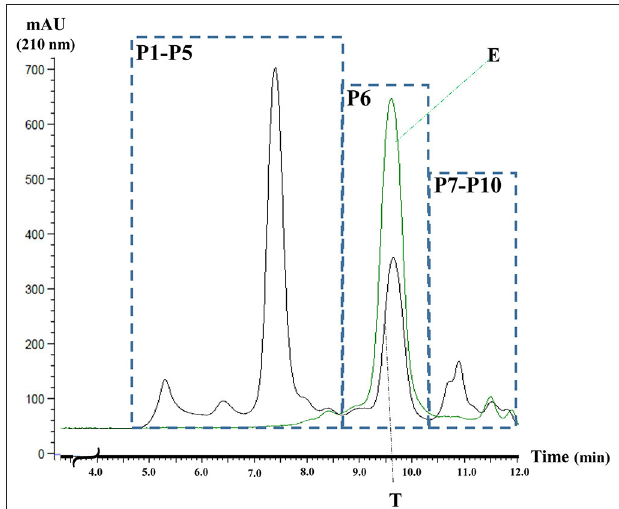
FIGURE 1 | The typical SE-HPLC profile of the total oat protein extract (T) and 70% ethanol extract of oat flour (E). AU, absorbance units at 210nm, P1-P5- polymer fraction, P6-avenins, and P7-P10-monomer